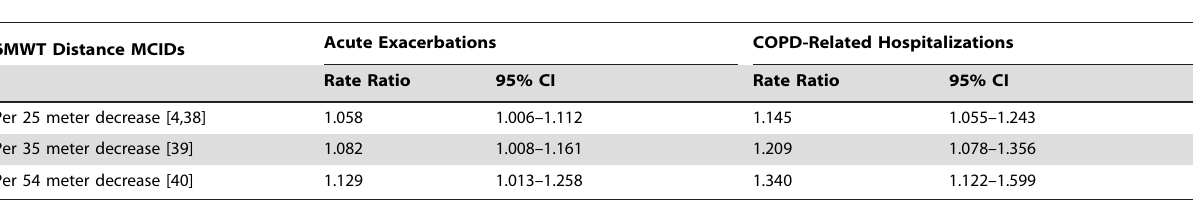
Table 6. Calculated Rate Ratios for Published MCIDs for 6MWT